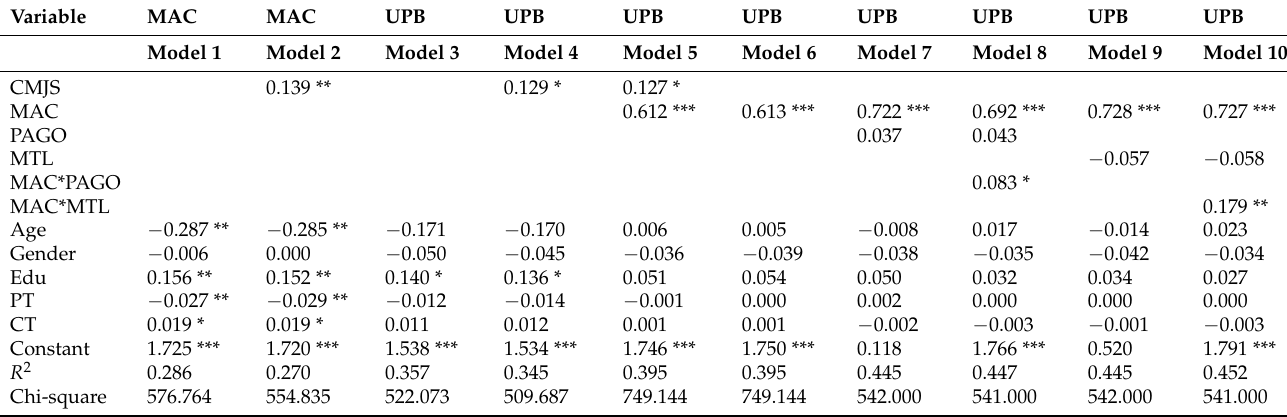
Table 3. Regression